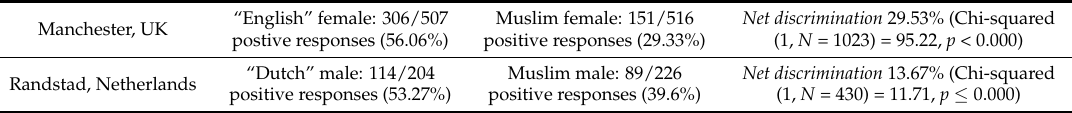
Table 1. Comparison of positive responses to the submitted CV of the Muslim applicant, in British and Dutch settings. “English” female: 306/507 postive responses